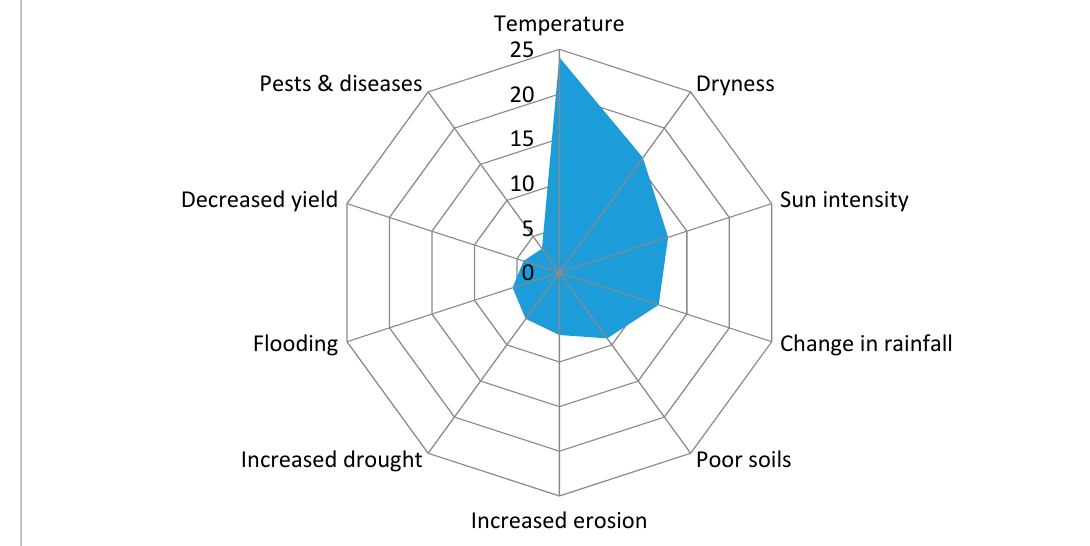
Figure 4. Web diagram of perception variables and percentage strength of variance from a principal component analysis (PCA). The blue colour represents variance which decreases in clockwise direction.